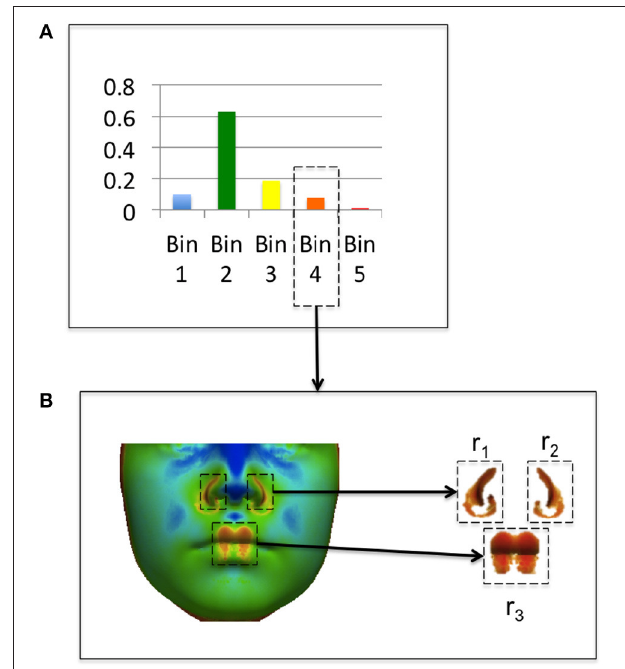
FIGURE 5 | Example of coherent region extraction from a feature histogram bin. The feature histogram from an individual is shown in (A) and coherent regions in bin 4 are shown in (B)